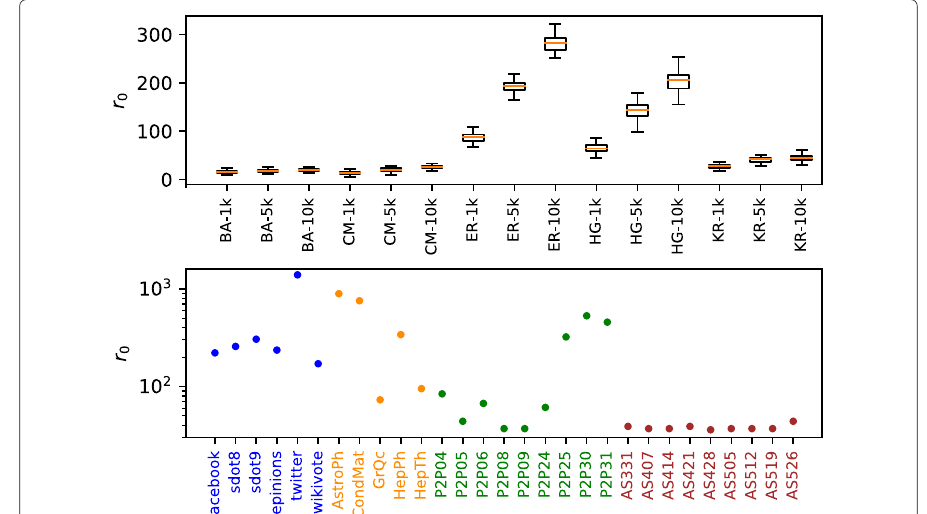
Fig. 7 Values of r 0 for random (top) and real (bottom) data sets. r 0 is the number of eigenvalues whose √ λ λ magnitude is greater than 1 , where 1 is the largest eigenvalue in magnitude, which is always